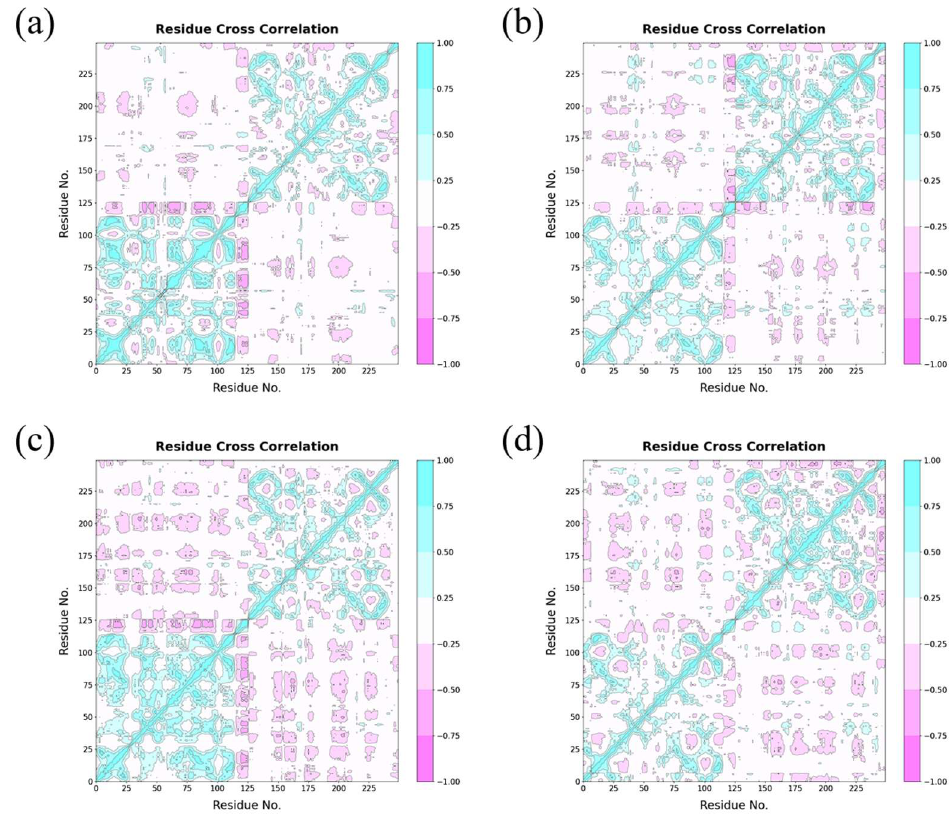
Figure 10. Cross-correlation matrixes of fluctuations in the x-, y- and z-coordinates for 𝐶 (cid:3080) atoms belonging to the PD-L1 dimer in the ( a ) capsaicin, ( b ) zucapsaicin, ( c ) curcumin and ( d ) 6-gingerol